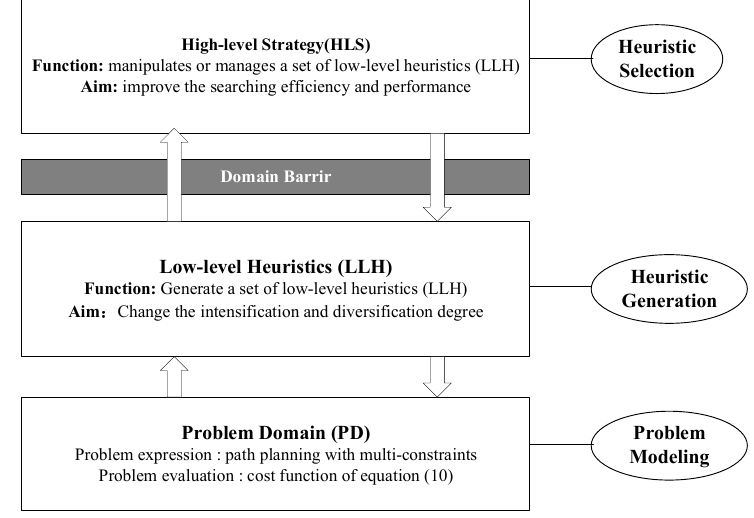
Figure 4. Hyper-heuristic framework and composition.